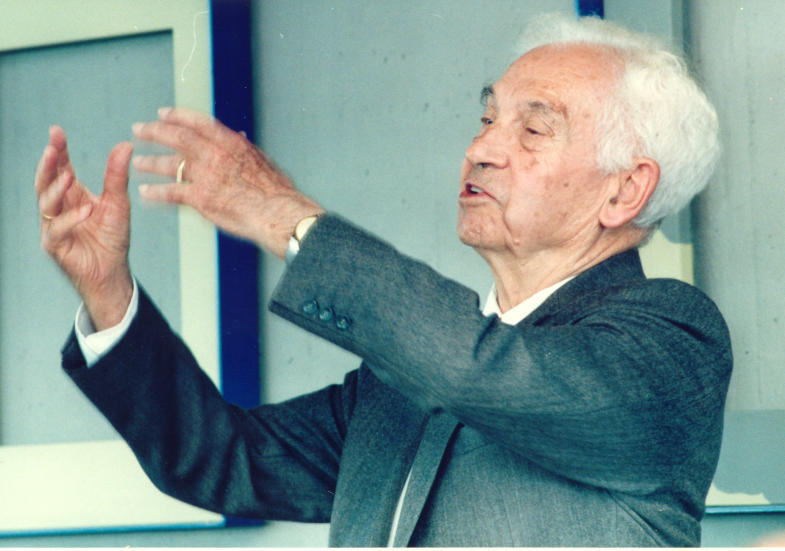
Ernst Mayr in 1994, after receiving an honorary degree at the University of Konstanz(Photo: University of Konstanz)